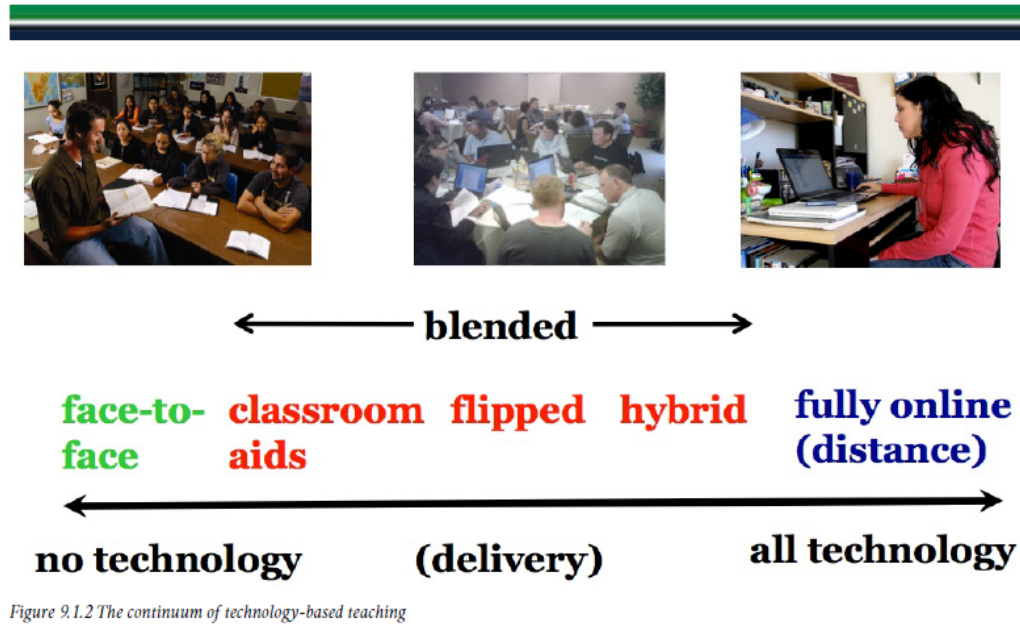
Figure 1 : The continuum of technology-based learning (Bates, 2015, p.